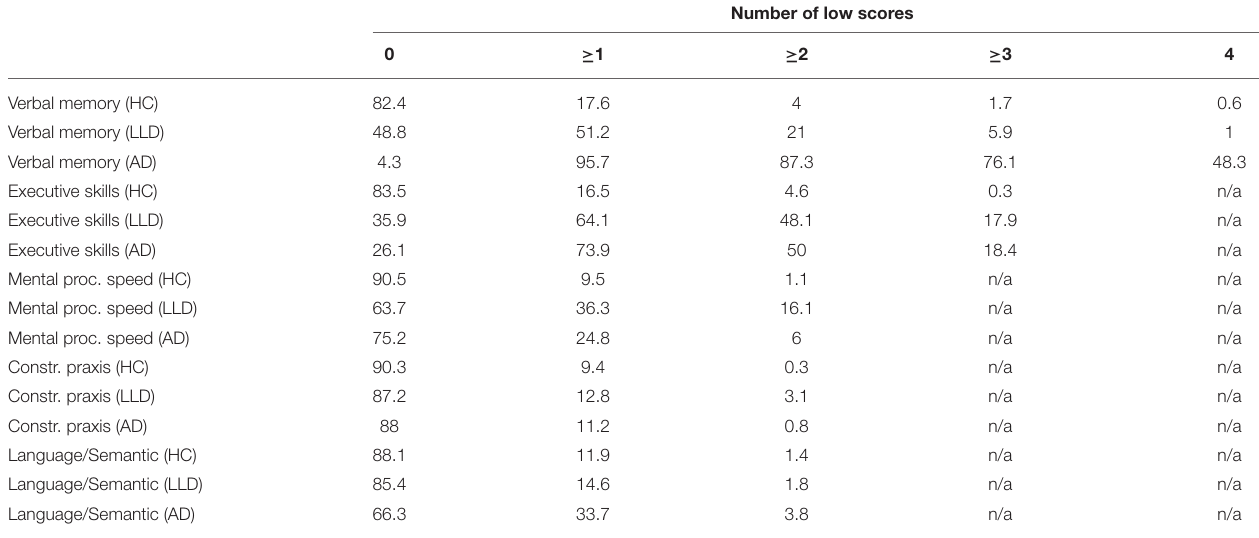
TABLE 2 | Base rates of low scores within specific cognitive domains of healthy controls and patients with late life depression and mild Alzheimer’s Disease. Number of low scores 0 ≥